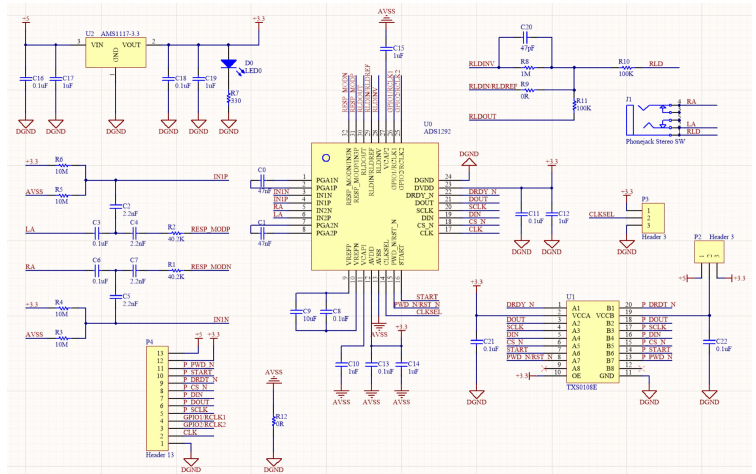
Figure 2. The circuit design of ECG signal sensor module.